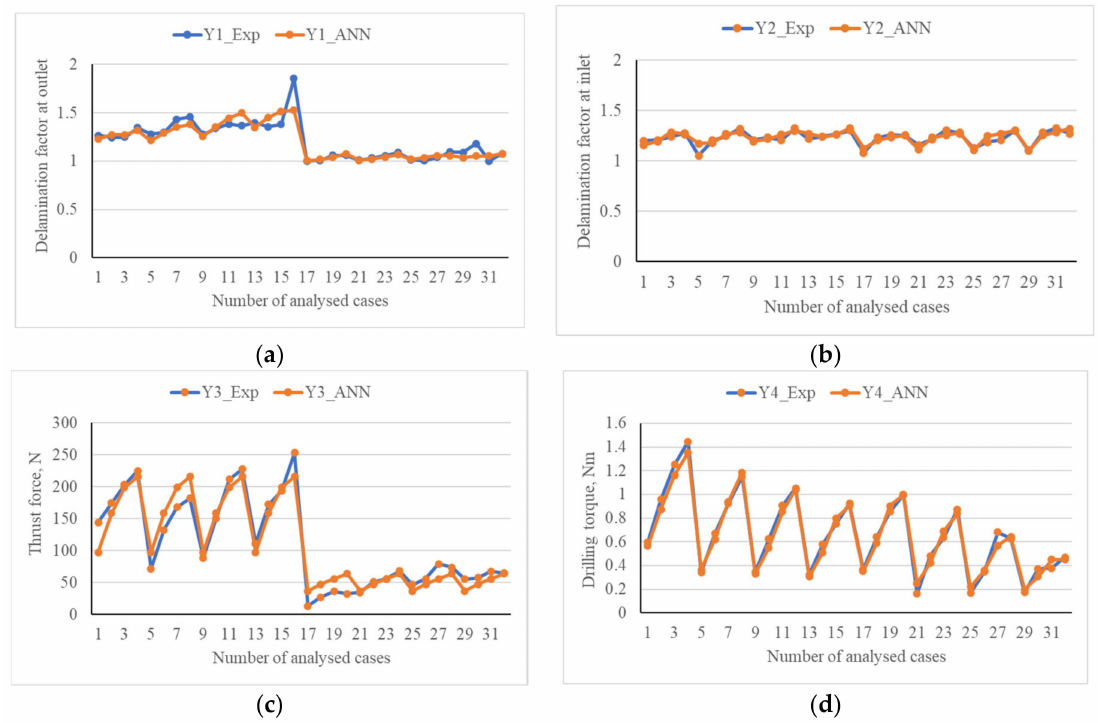
Figure 2. Comparison between predicted vs. experimental values: ( a ) delamination factor at the outlet; ( b ) delamination factor at the inlet; ( c ) thrust force; ( d ) drilling